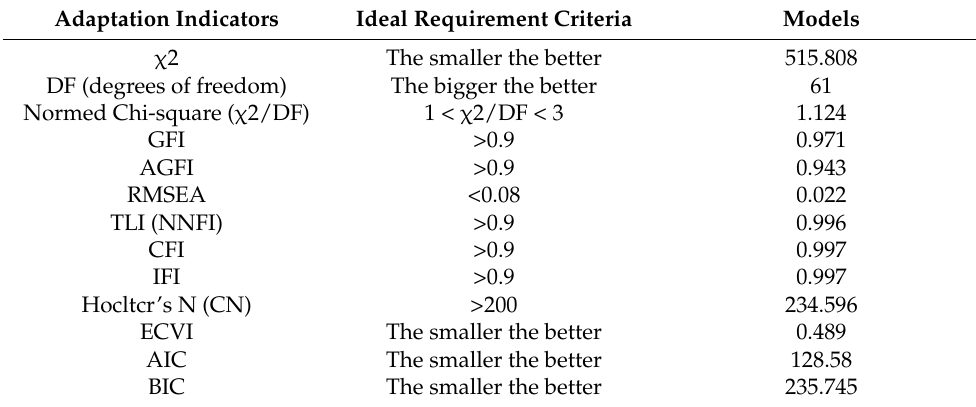
Figure 2. Statistical model of the structure of expectations for experiential learning in mathematics. Table 3. Overall model fit of the desired model.